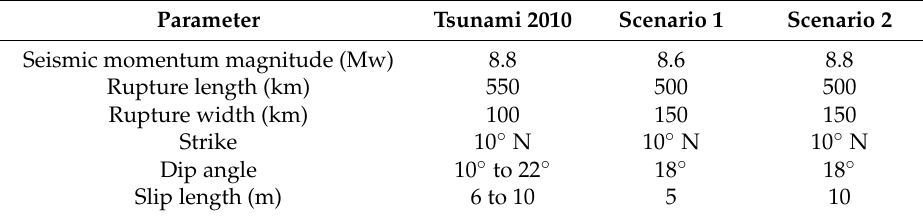
Table 1. Seismic design parameters used in the tsunami modeling, obtained from